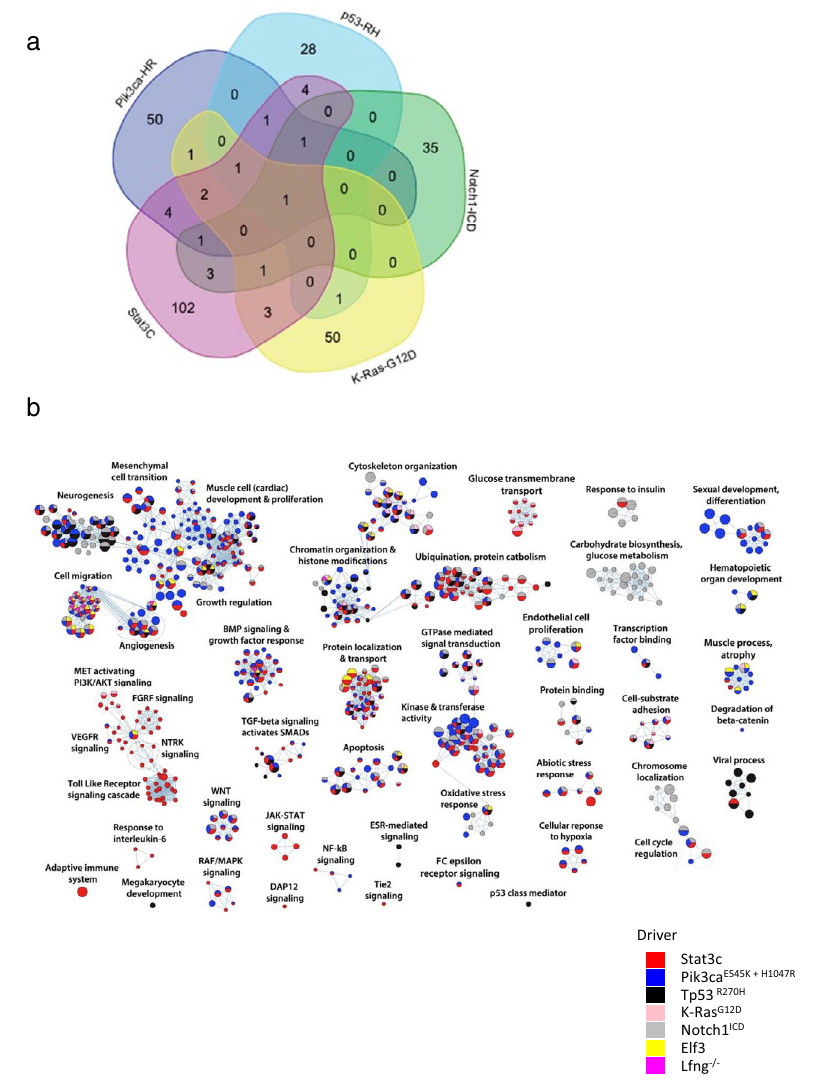
Fig. 2 Pathway analysis identi fi es shared and driver-speci fi c pathways and processes in transformation of mammary epithelium. a Overlap of clonal gCIS identi fi ed in GEMM-speci fi c cohorts. b Pathways altered by SB mutagenesis in GEMM-speci fi c subscreens (FDR corrected P -value < 0.05). Enrichment map shows enriched pathways and processes as nodes, while pathways with many shared genes are connected and cluster into subnetworks. Node colors indicate cohorts where gCIS events were enriched in the corresponding pathways. One-sided ranked hypergeometric tests were used and signi fi cant pathways visualized. p -value information for nodes are found in Supplementary Data